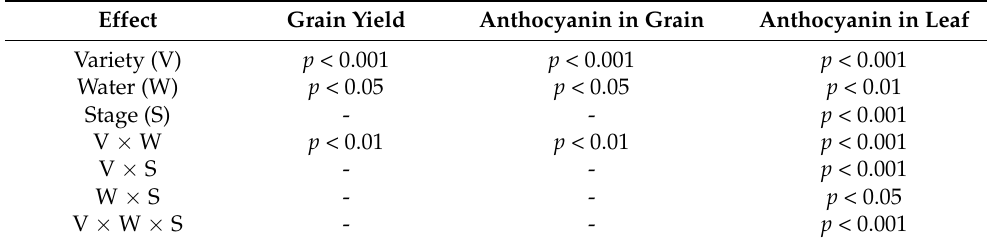
Table 1. Significant effects by ANOVA of variety, water and growth stage on grain yield and anthocyanin in grain and leaf of 5 purple rice varieties grown in waterlogged and aerobic condition. Effect Grain